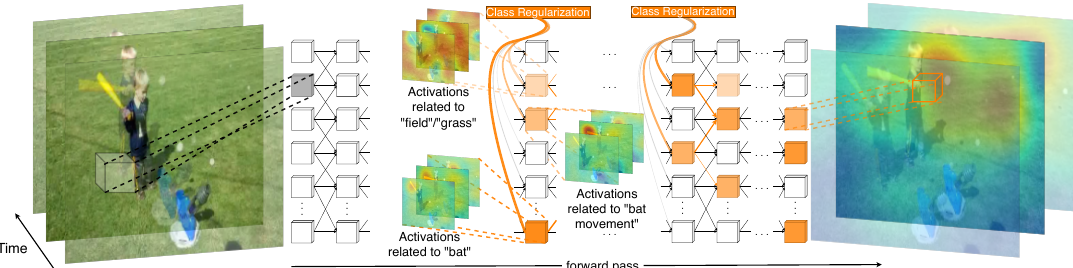
Figure 3. Visualization of feature amplification. As class-specific activations are reused by the network, informative spatiotemporal features for specific classes during an iteration are amplified. The effect of this amplification is propagated to deeper layers in the network through the connections of the layers in which Class Regularization is